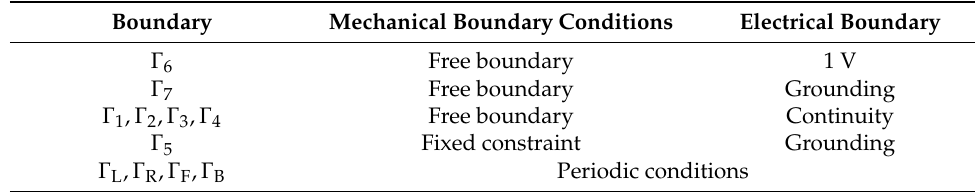
Table 2. Mechanical and electrical boundary conditions.